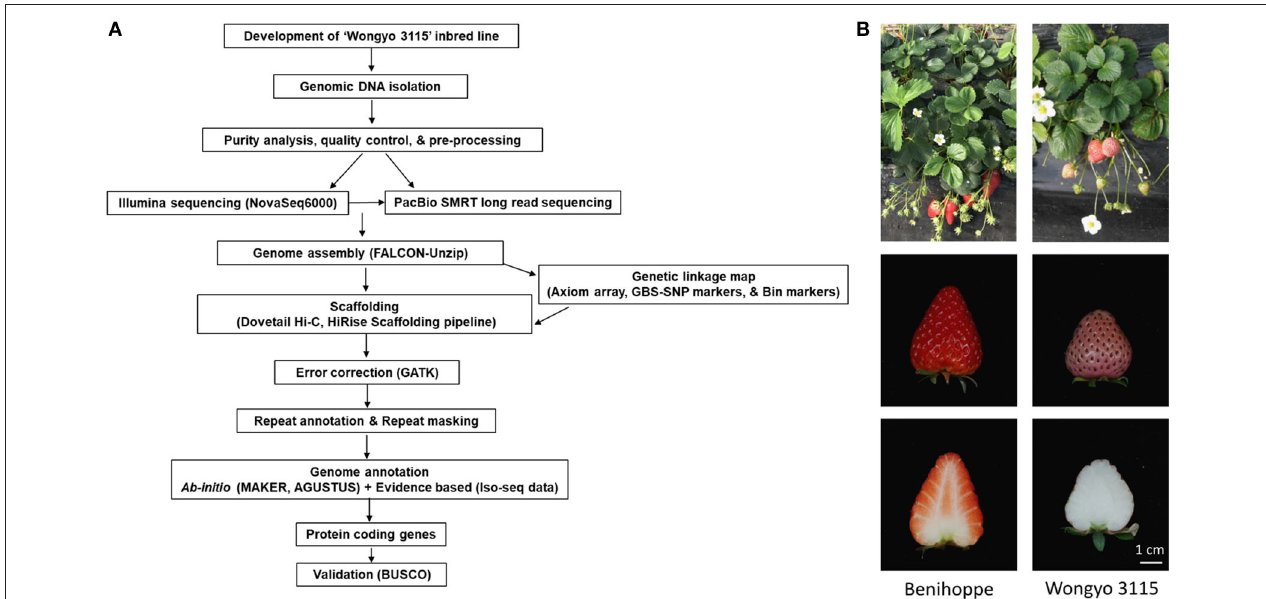
FIGURE 1 | (A) An overview of the workflow pipeline employed in this study. (B) The phenotype of the ‘Wongyo 3115’ homozygous inbred line and its parent ‘Benihoppe’.